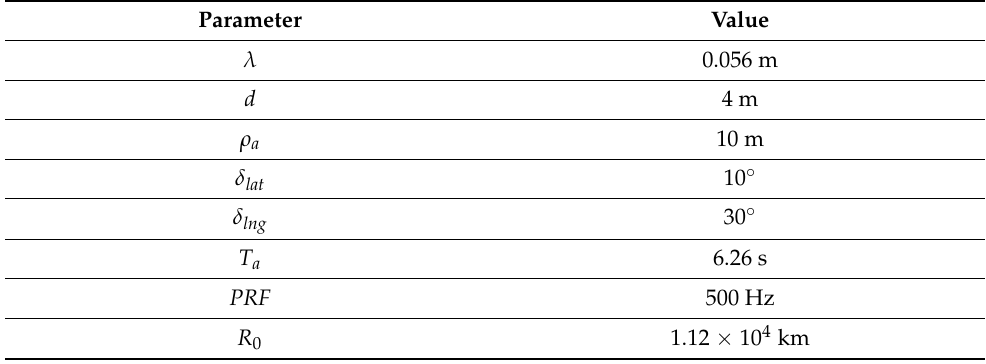
Figure 3. Dependency between the phase error and v ta and v tr . ( a ) The reference channel, ( b ) the 2th channel, and ( c ) the difference between phase error in the reference channel and the 2th channel. The target’s accelerations are set to be: a ta = 0.5 m/s 2 , a tr = − 0.4 m/s 2 . In the figures, the color indicates the value of the phase error, and the unit is radian. Table 2. Parameters of the MEO SAR and the target for the